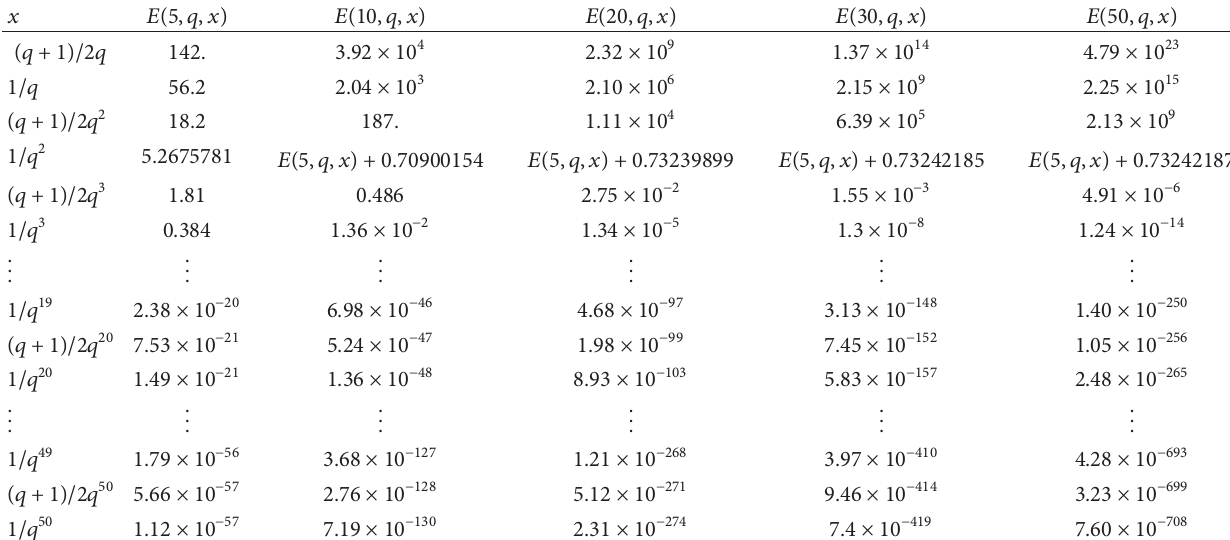
Table 2: The values of 𝐸(𝑛,𝑞,𝑥) = 𝐵 𝑛,𝑞 (ℎ; 𝑥) − ℎ(𝑥) for 𝑞 = 2 at some points 𝑥 ∈ [0,1]